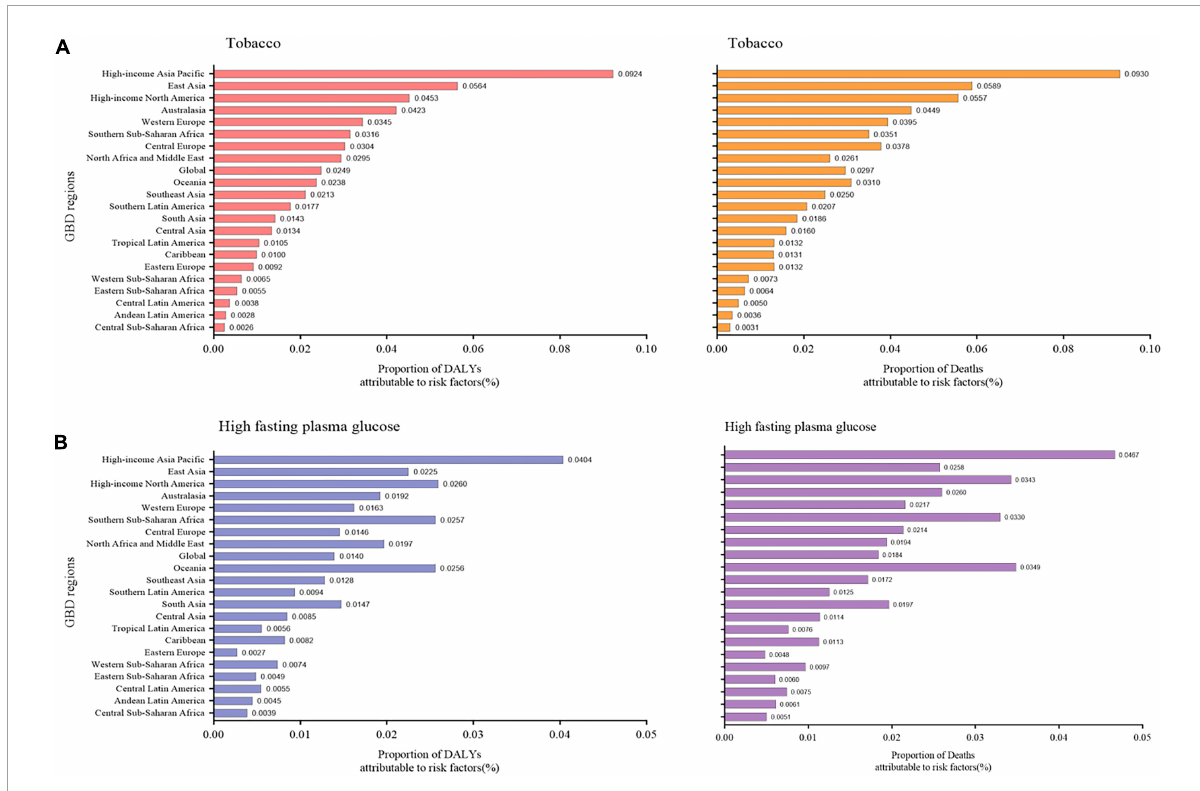
FIGURE4 Proportion of NAFLD DALY and deaths attributable to (A) tobacco and (B) high fasting plasma glucose for 21 GBD regions, 2019. NAFLD, non-alcoholic fatty liver disease; DALY, disability-adjusted life